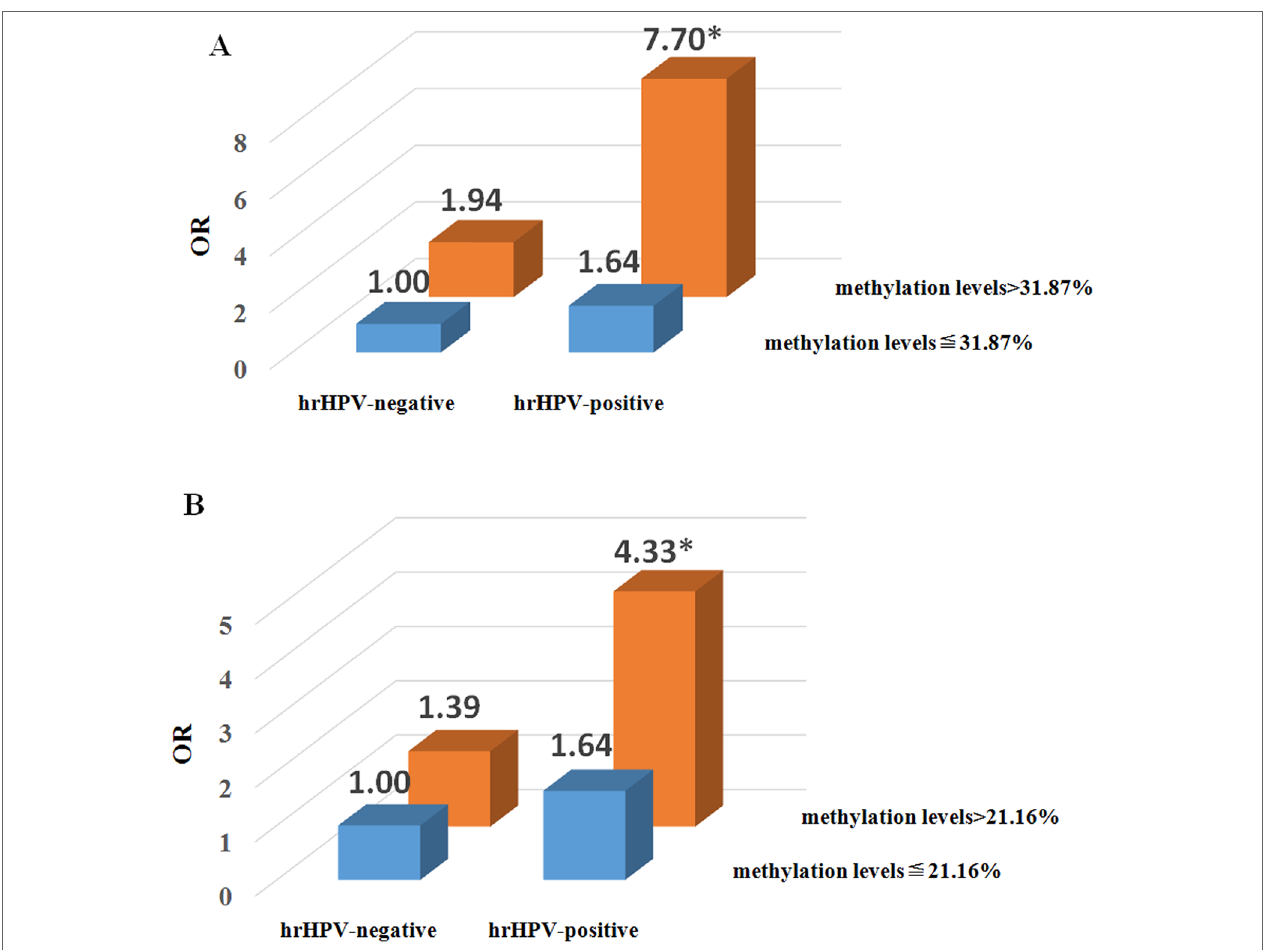
FiGURe 3 | Risk analysis of the two-factor interaction of high-risk human papillomavirus (hrHPV) and promoter methylation levels in the cervical precancerous lesion (CPL). (A) The interaction between hrHPV and methylation level of cyclic GMP-AMP synthase (cGAS) . The reference group is the combination of hrHPV- negative (including lrHPV-positive and HPV negative individuals) and cGAS methylation levels ≦ 31.87%. * P 0.001, adjusted odds ratio (OR) on age and number of pregnancies. (B) The interaction between hrHPV and methylation level of mitochondrial antiviral-signaling (MAVS) . The reference group is the combination of hrHPV- negative (including lrHPV-positive and HPV negative individuals) and MAVS methylation levels ≦ 21.16%. * P = 0.001, adjusted OR on age and number of pregnancies.